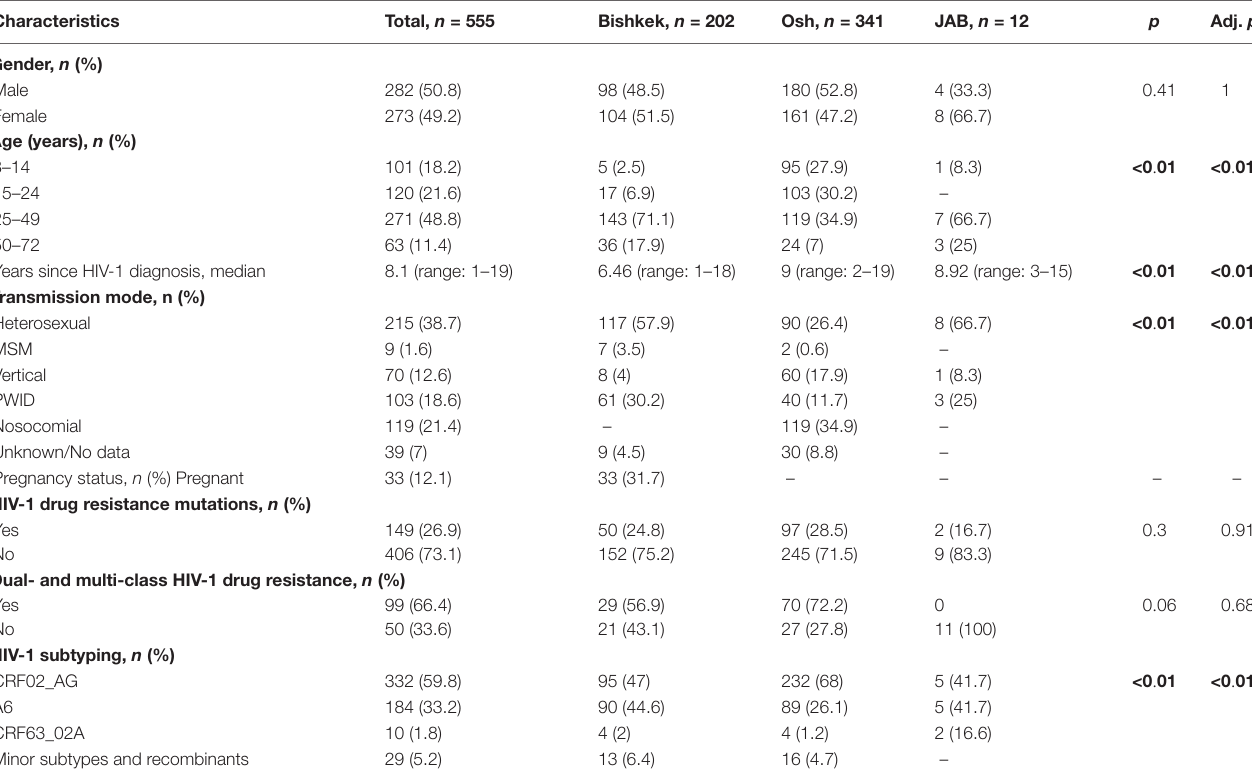
TABLE 1 | Demographic and HIV-related characteristics of the 555 study individuals. Characteristics